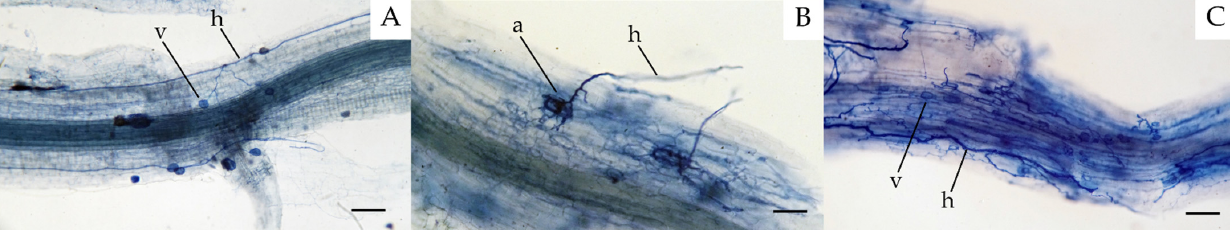
Figure 7. Micrographs of teak roots colonized by arbuscular mycorrhizal fungi. Teak roots were stained with 0.05% trypan blue before micrography under a light microscope, where a = appressorium, h = hypha, and v = vesicle of fungi. Root samples were collected from different treatments in pot experiments, including a non-inoculated control ( A ), the treatment inoculated with Kitasatospora sp. TCM1-050 and Claroideoglomus sp. PBT03 ( B ), and the treatment inoculated with every tested microbe ( C ). Scale bars = 10 µm.